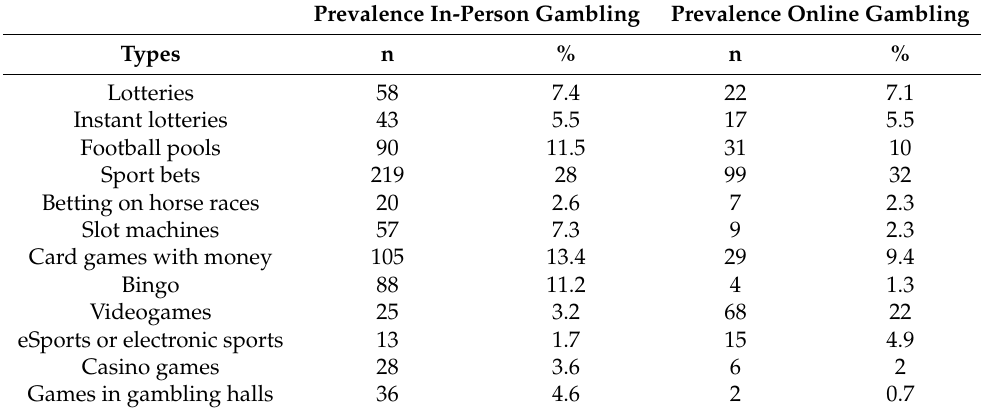
Table 2. Prevalence of the frequency of the type of game according to the